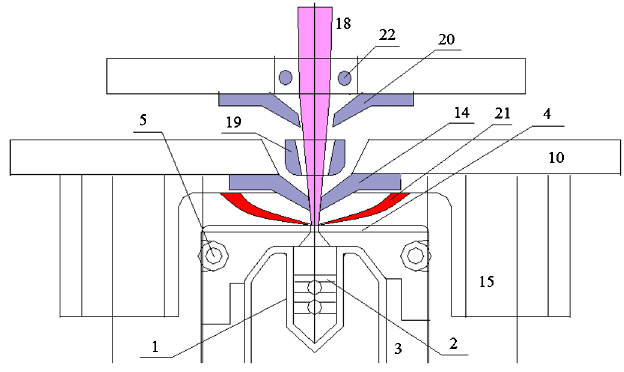
FIG. 5. Extraction system of PD SPS. (1) cathode; (2) anode; (3) source body; (4) cooled plasma plate; (5) anode cooling; (14) extractor; (15) magnet; (18) negative ion beam; (19) suppressor/ deflector; (20) acceleration electrode; (21) electron flux; (22)